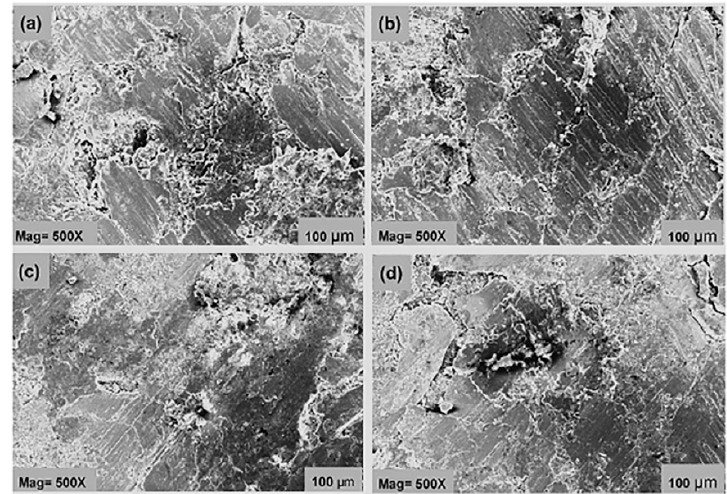
Figure 13. The worn surface under the scanning electron microscope. ( a ) C 0 ; ( b ) C 1 ; ( c ) C 2 ; ( d ) C 3 .